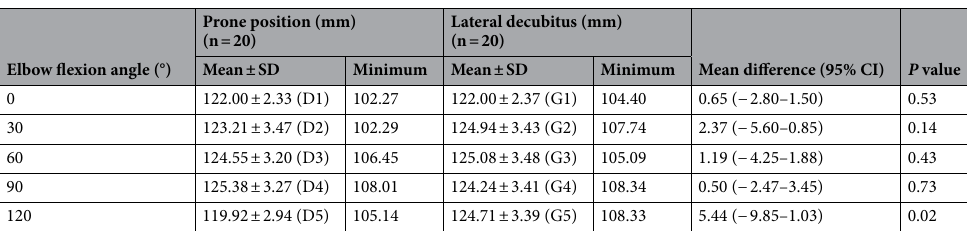
Table 3. Distances from the lateral epicondyle to the lateral intermuscular